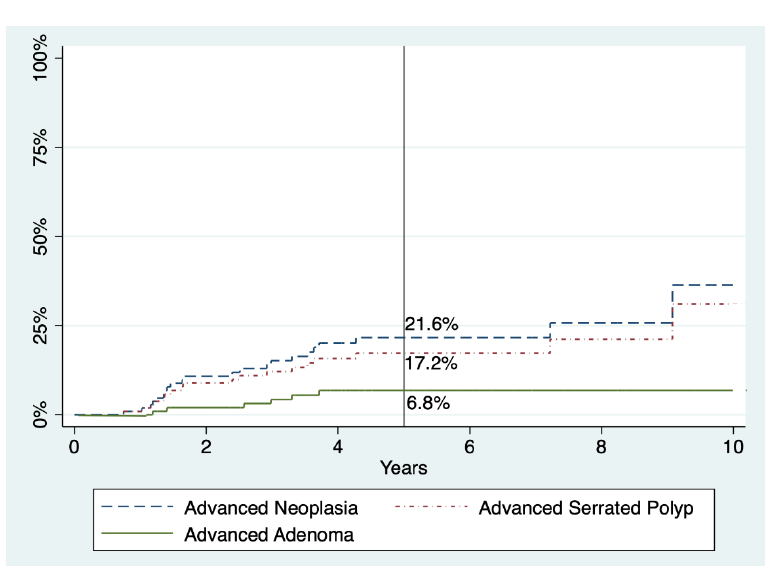
Figure 2. Cumulative incidences of advanced adenoma, advanced serrated polyp, and advanced neoplasia within follow-up in patients with SPS. Percentages refer to cumulative incidence at five years.